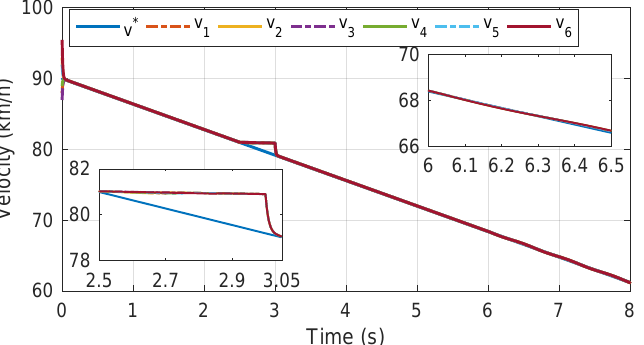
Figure 14. Velocity curve of each carriage with the proposed observer-driven consensus braking control strategy in case 3.